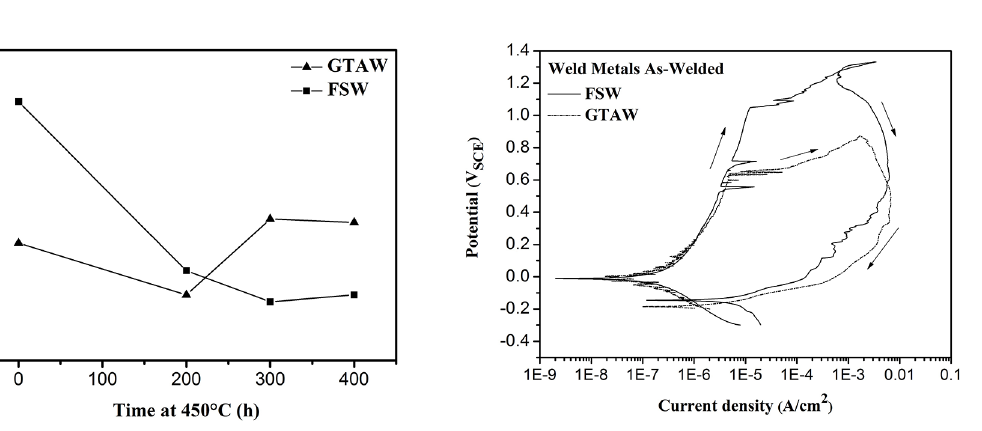
Figure 10. Surface of weld metal fracture GTAW aged for 200 h.